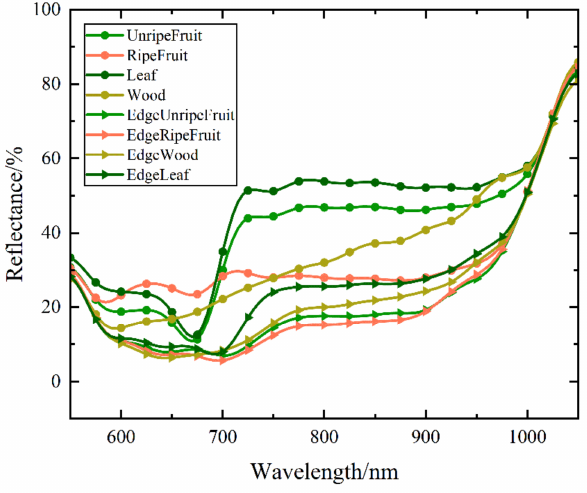
Figure 8. Reflectance of the edge and nonedge of the persimmon